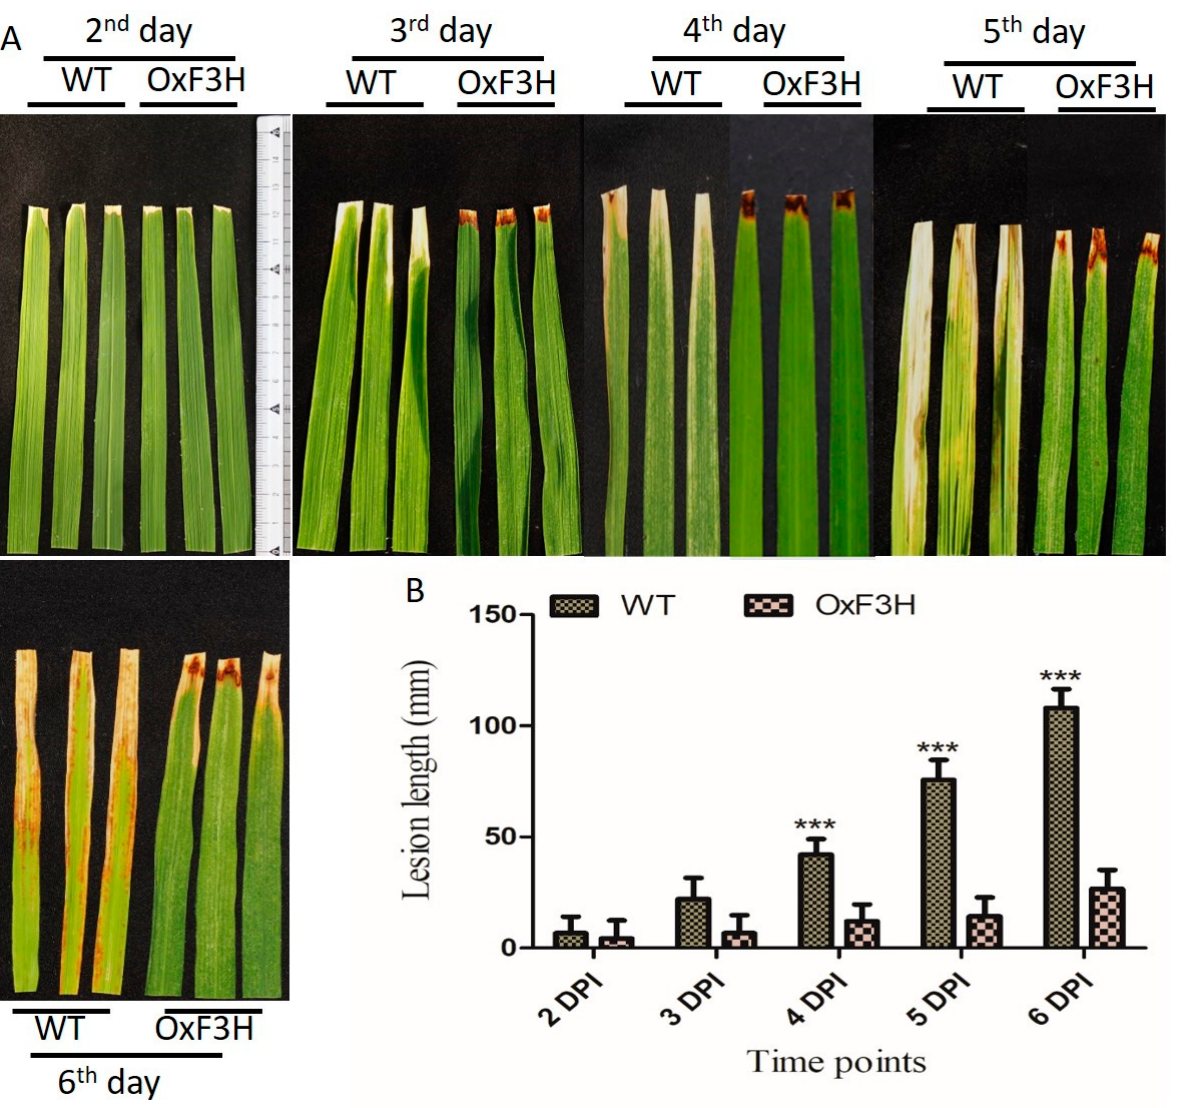
Figure 2. Identification of bacterial leaf blight infection leaf lesion length between OxF3H and WT line. ( A ) Pictorial representation and ( B ) quantitative representation of lesion lengths. Bars indicate mean ± standard deviation and *** show a significant difference ( p ≤ 0.001), as analyzed using two-way ANOVA and a Bonferroni posttest. Data were collected after the second day of BLB infection every day until the sixth DPI.